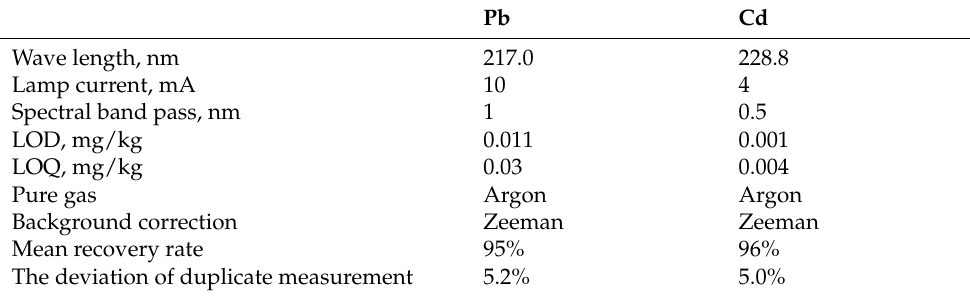
Table 1. Measurement parameters for the determination of Pb and